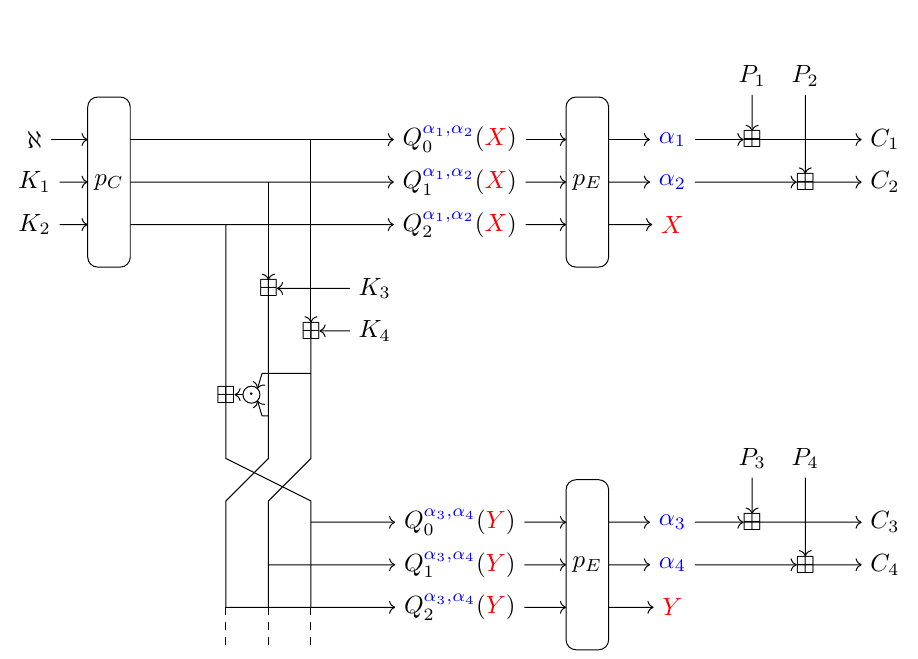
Figure 11: How to generate equations for